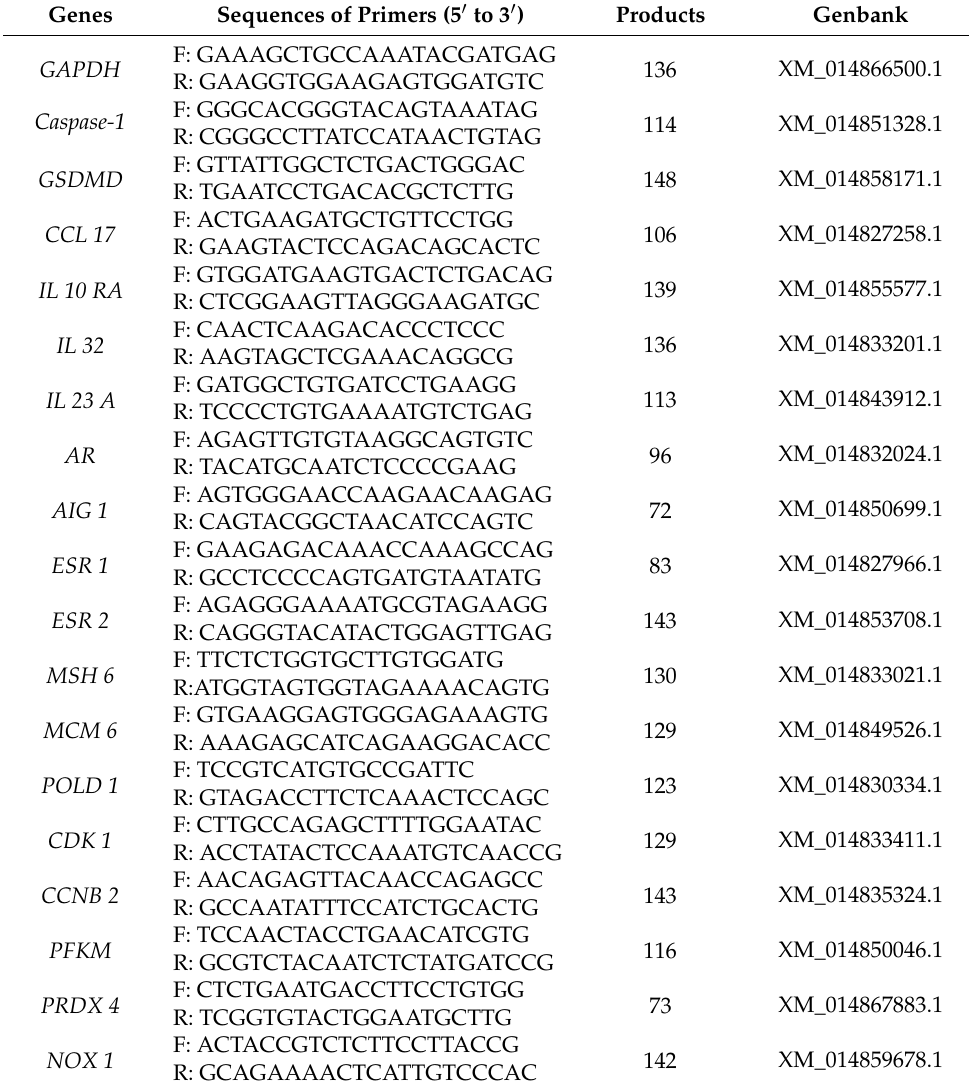
Table 2. Primers used for quantitative-PCR. Genes Sequences of Primers (5 (cid:48) to 3 (cid:48) ) Products